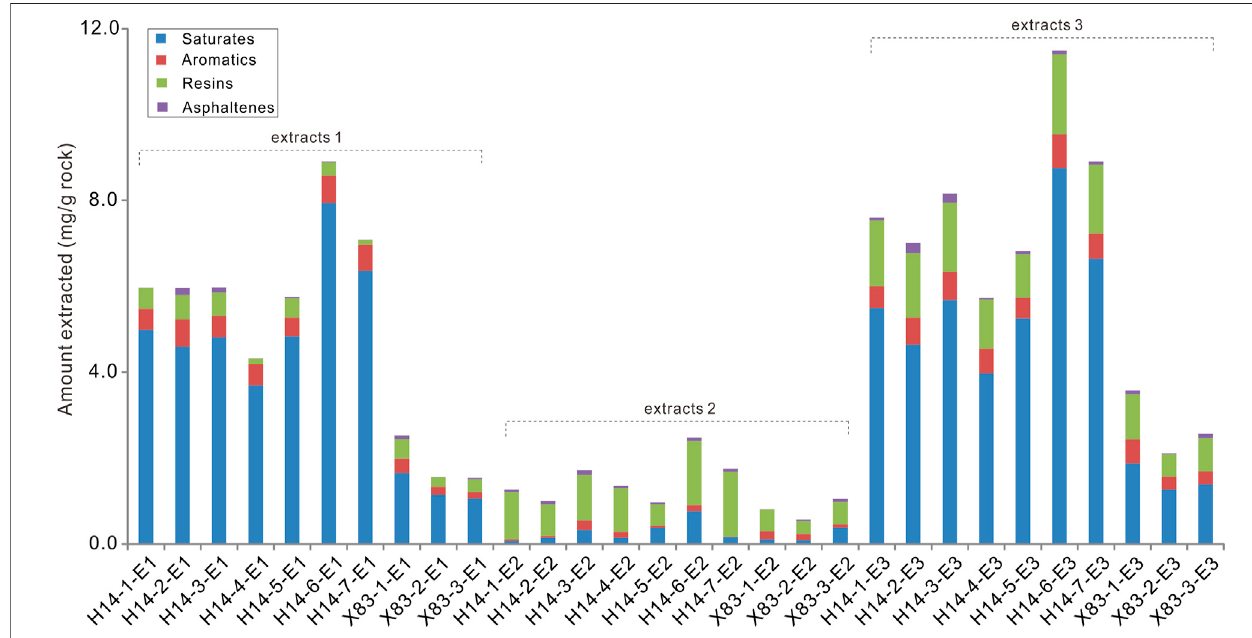
FIGURE 3 | Amount of organic matters extracted in the organic solvents.